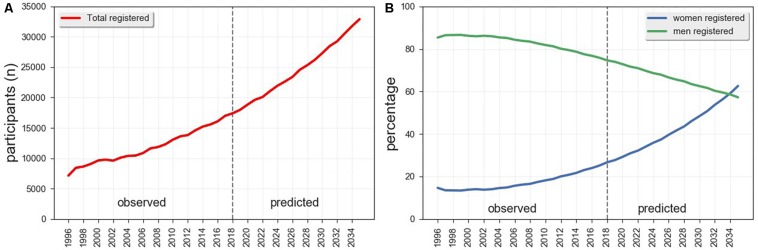
EWMAs for observed and predicted entries of (A) total participants and (B) percentage of men and women registering in the main race. The EWMAs are computed with a span of 6 years.